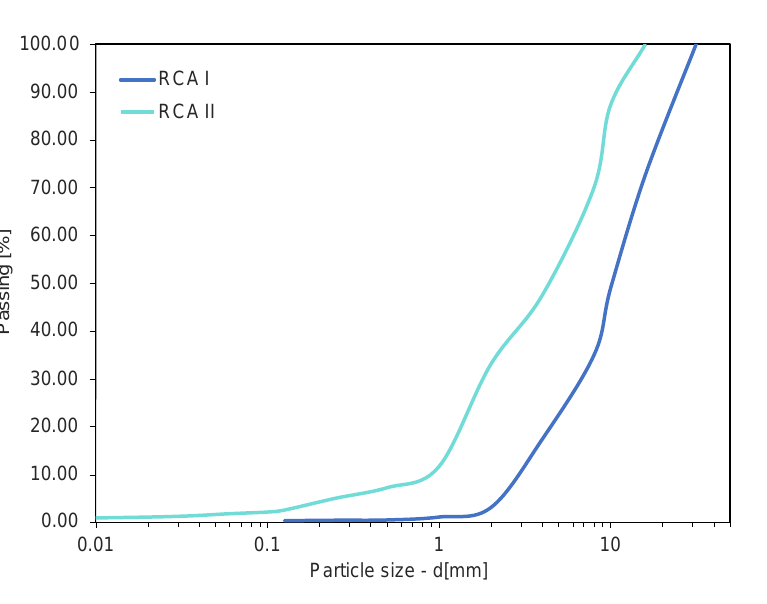
Table 1. Average values of parameters of physical properties of materials.